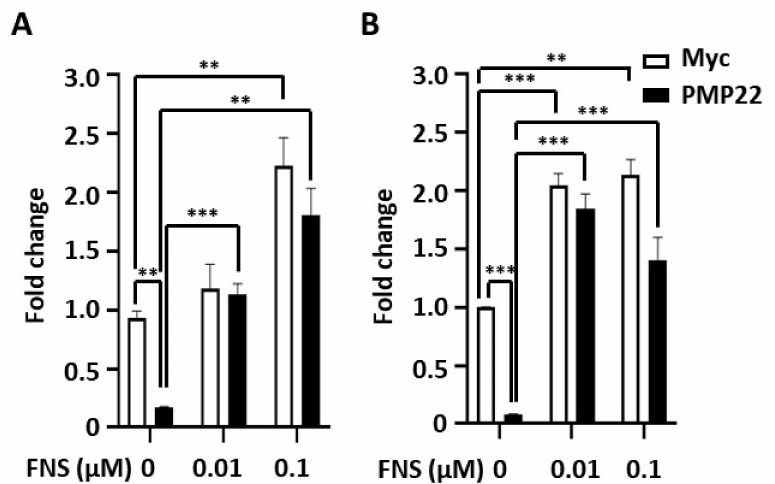
Figure 2. Changes in myelin gene expression by farnesol. After transfection of pCMV-myc- PMP22 or pCMV-myc vector into RT4 cells, cells were treated with 0.01 µ M and 0.1 µ M of farnesol for 48 h. ( A ) Oct6 mRNA levels were determined by RT-PCR. ( B ) Changes in MPZ mRNA levels were determined by RT-PCR. ** p < 0.01; *** p <